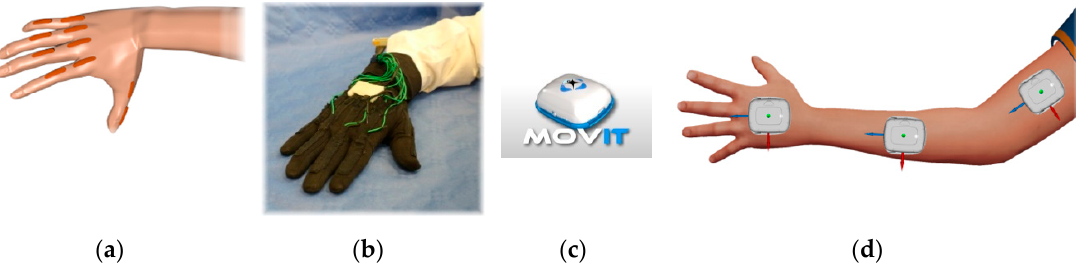
Figure 1. ( a ) Arrangement of the ten flex sensors on top of the carpal–metacarpal and metacarpal– phalangeal joints of the fingers. ( b ) The sensory glove equipped with the ten flex sensors, singularly hosted in one pocket each. ( c ) The inertial measurement units termed Movit. ( d ) Arrangement of the inertial measurement units (IMUs) on the dorsal aspect of the hand, on the forearm and arm, for both of the upper limbs.